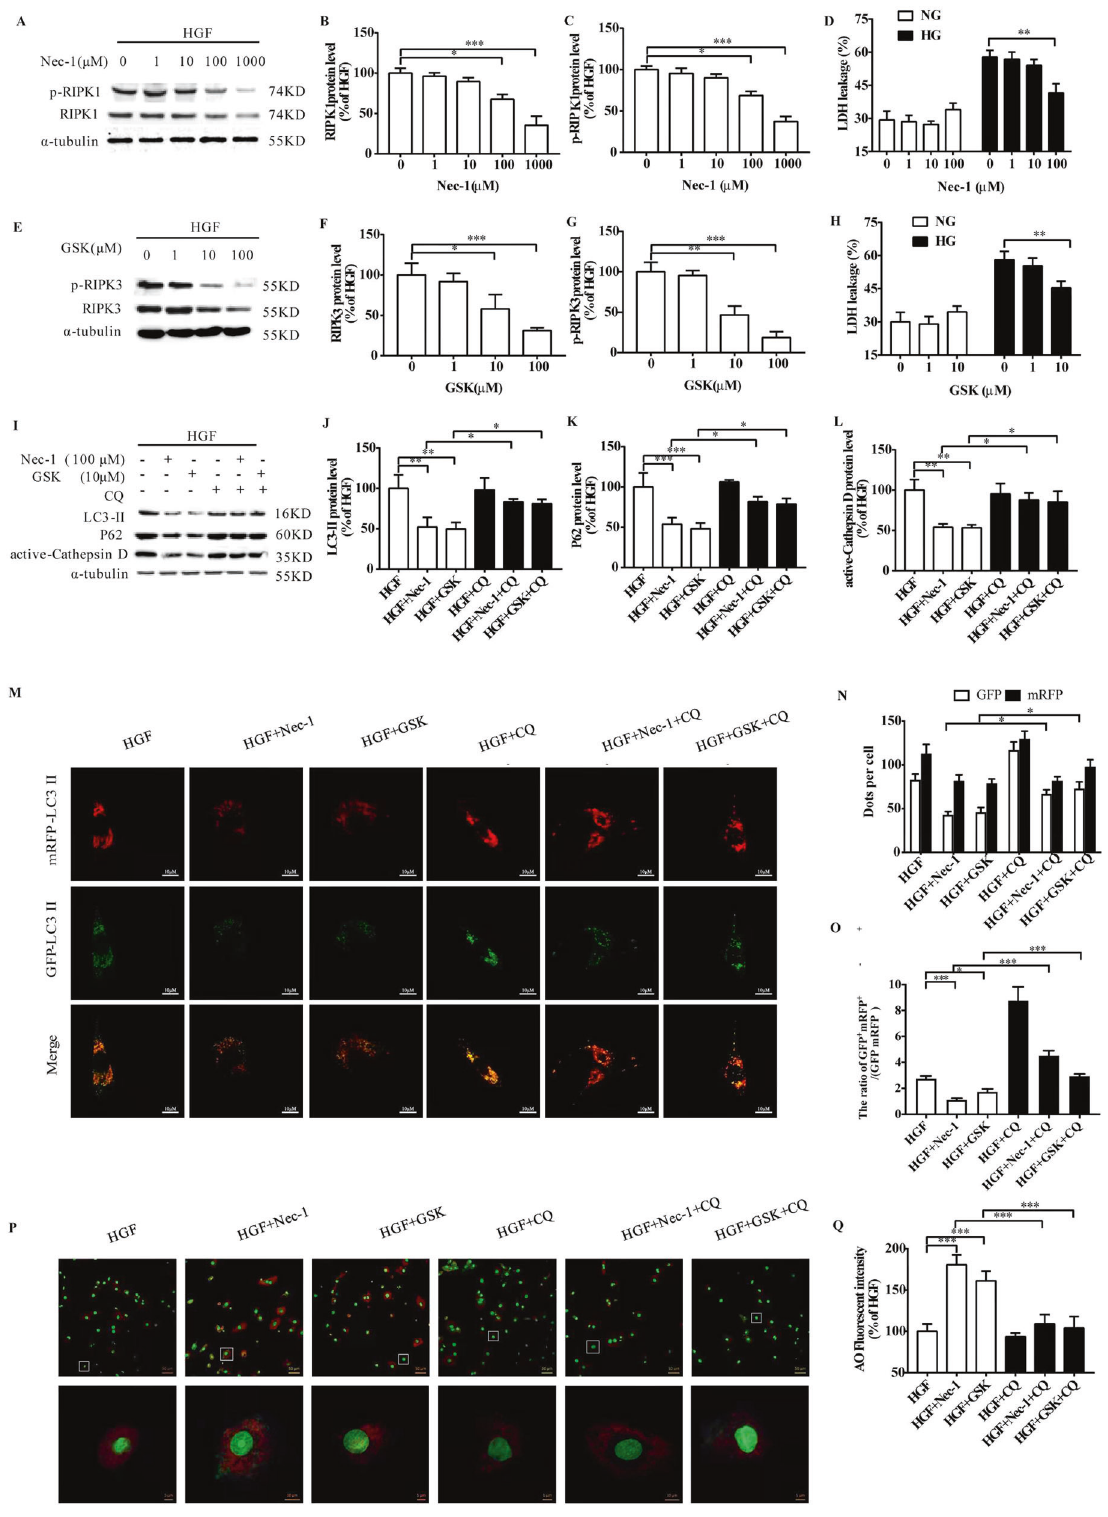
Fig. 3 Pharmacological blockade of autophagy neutralizes the effects of RIPK1/RIPK3 inhibition. Representative images and percentages of RIPK1/ser166-p-RIPK1 ( A – C ), RIPK3/ser232-p-RIPK3 ( E – G ), and LDH leakage ( D , H ) following treatment Nec-1 (100 μ M) and GSK (10 μ M). Representative images and percentages of LC3-II, P62, active-cathepsin D ( I – L ); Confocal images and the ratio of GFP + mRFP + /(GFP - mRFP + ) and AO fl uorescence intensity ( M – Q ). n = 3 per group. Means ± SD. * P < 0.05, ** P < 0.01, *** P < 0.001. NGF normal glucose and fat group, HGF high glucose, and high fat group, Nec-1 necrostatin-1, GSK GSK872, CQ, chloroquine, AO acridine orange.